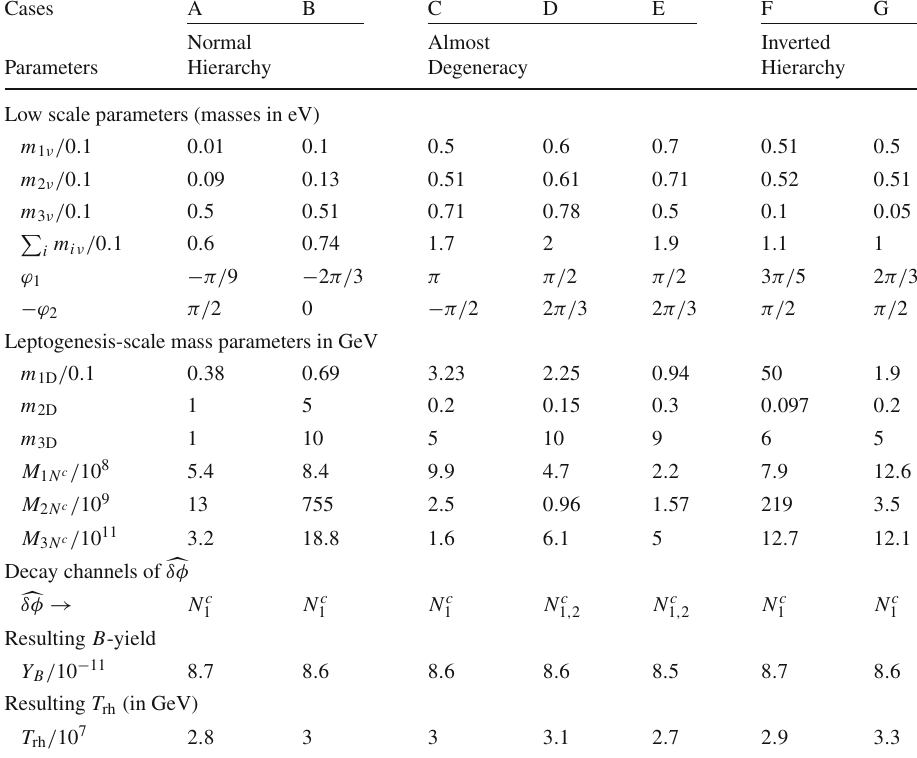
Table 5 Parameters yielding the correct BAU for K = K 1 or K 2 , (cid:5) M BL (cid:6) = 10 12 GeV, n = 0, λ μ = 10 − 6 , y = 0 . 5 and 3 various neutrino mass